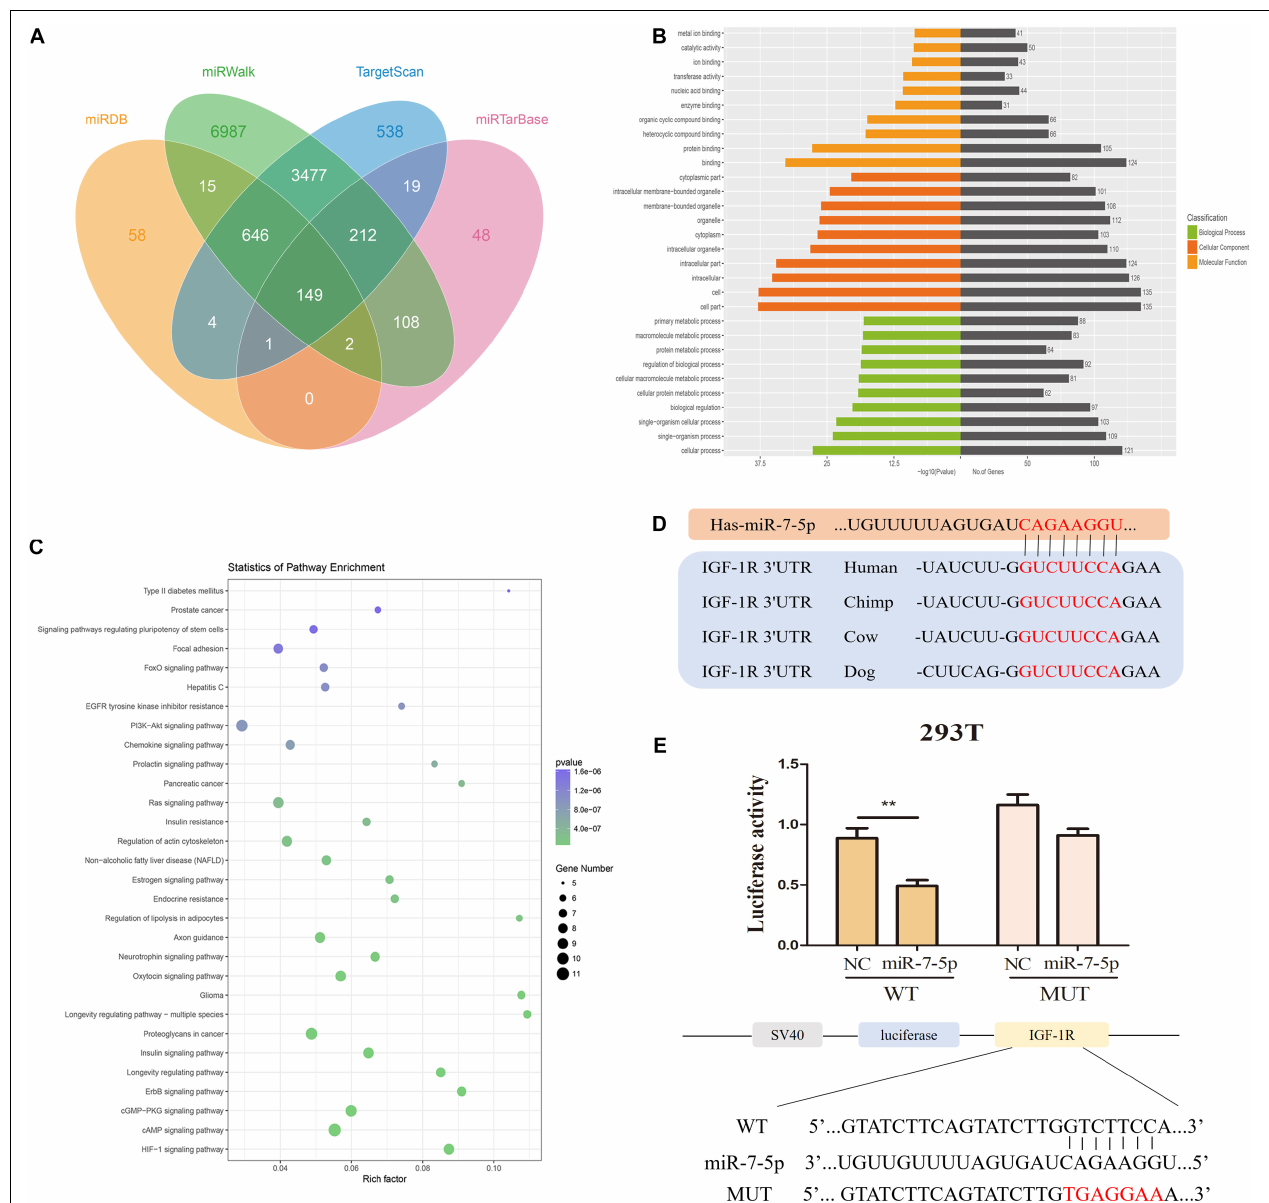
FIGURE 6 | MiR-7-5p directly targets IGF-1R. (A) Venn diagram of four datasets (miRDB, miRTarBase, miRWalk, and TargetScan) showed miR-7-5p predicted target genes. (B) Gene Ontology (GO) is a commonly used approach for annotating genes and gene products with functions including molecular function, biological process, and cellular component. GO analysis showed the top 10 GO terms of each function which sorted by P -value. (C) Kyoto Encyclopedia of Genes and Genomes (KEGG) pathway analysis showed that target genes were enriched in regulation of significant signaling pathways. (D) The binding sequences between miR-7-5p and IGF-1R were predicted online. The red letters delegate the binding sequence of miR-7-5p. (E) Luciferase activity in 293T further illustrated that miR-7-5p could bind with IGF-1R (** P <